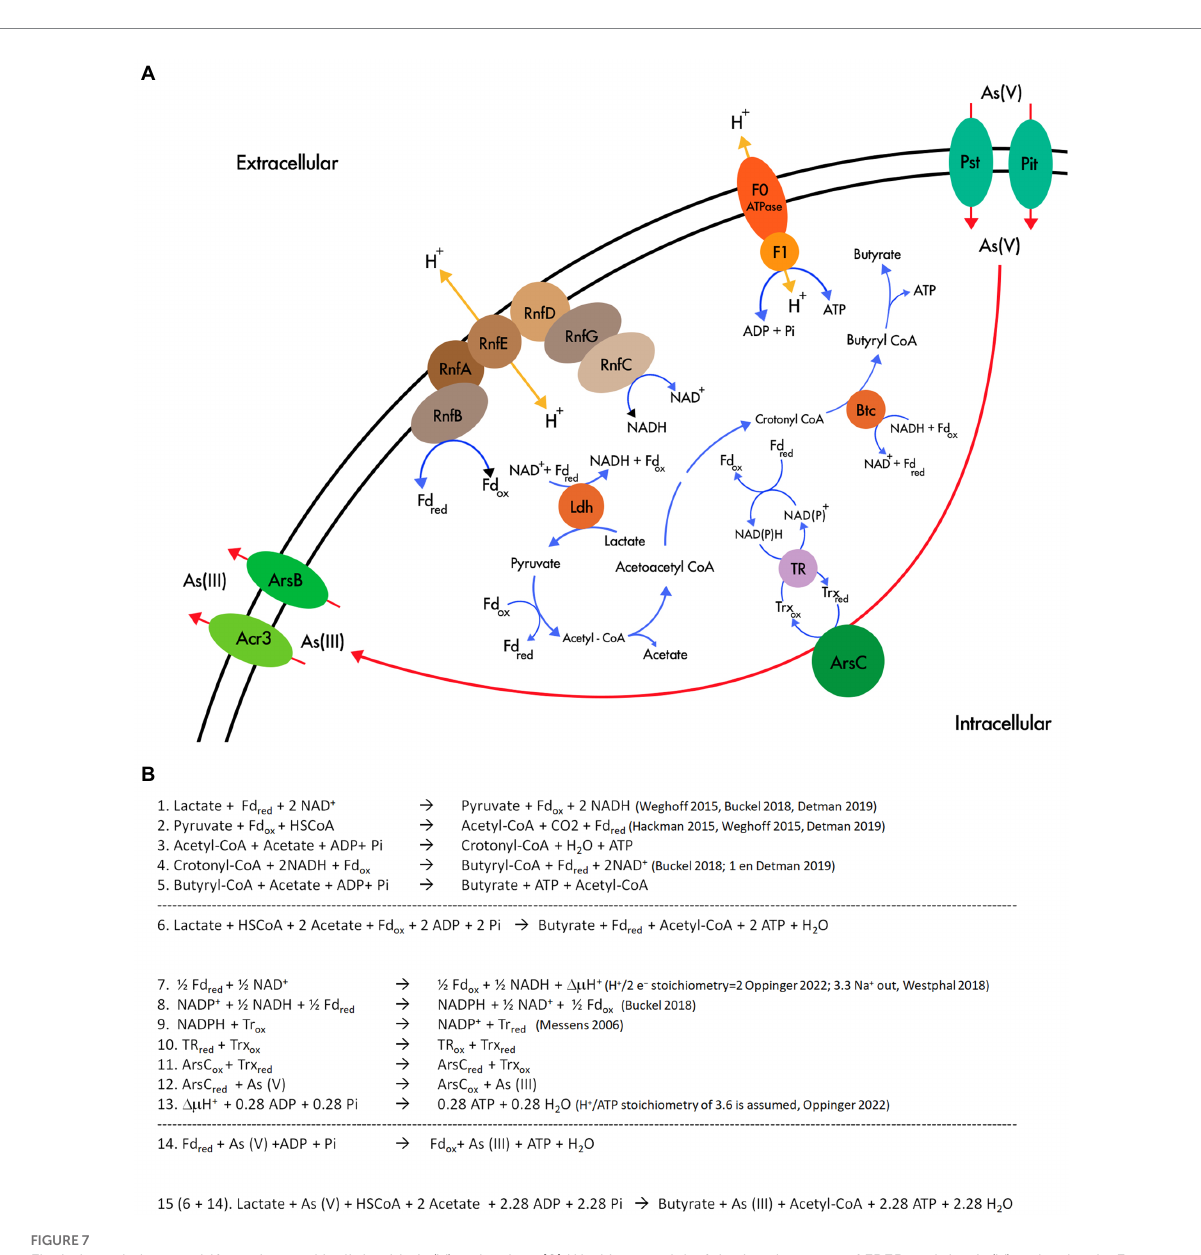
FIGURE 7 Flavin based electron bifurcation and its link with As(V) reduction. (A) Working model of the involvement of FBEB and the As(V) reduction in Fas . (B) Stoichiometry of the metabolism proposed in (A)